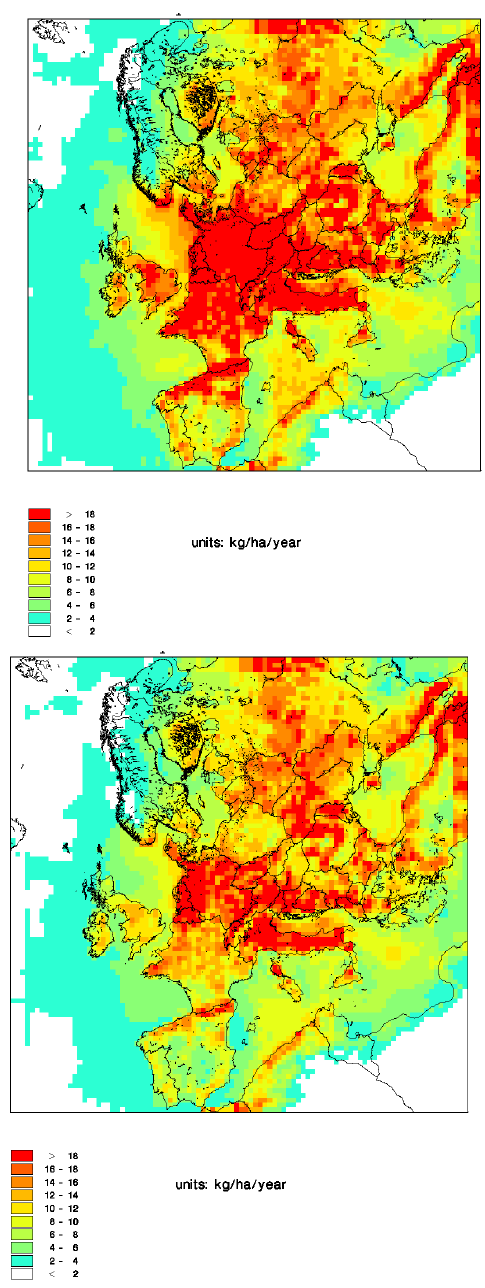
Fig. 3. Simulated total annual deposition of nitrogen across Europe, based on emissions from all present day (2007) sources (top) within the model domain and the projected emissions for 2020 (bottom). The common unit for nitrogen deposition [kgNha − 1 ] is used. Mul- tiply with 100 to convert to [kgNkm − 2 ].